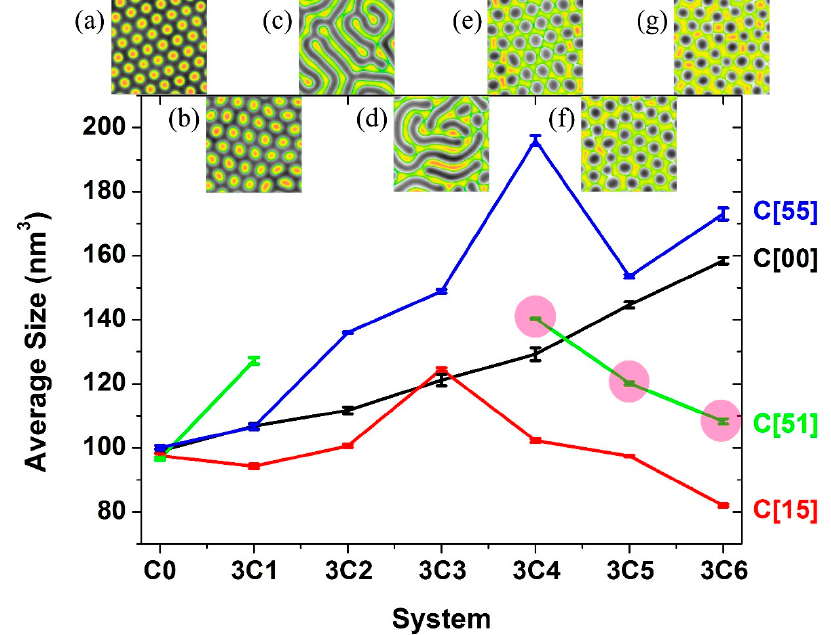
Figure 1. Average sizes of different systems forming the cylindrical structure. The black, blue, red, and green lines correspond to the interactions of C[00], C[55], C[15], and C[51], respectively. The two missing points on the green line are the systems assembled into non-cylindrical structures. The three pink circle-marked points are the systems assembled in the reverse micellar structure. The subfigures ( a )–( g ) are the density slices at the final equilibrium state along the X–Y plane for the systems from C0 to 3C6 under C[51] interaction, respectively.